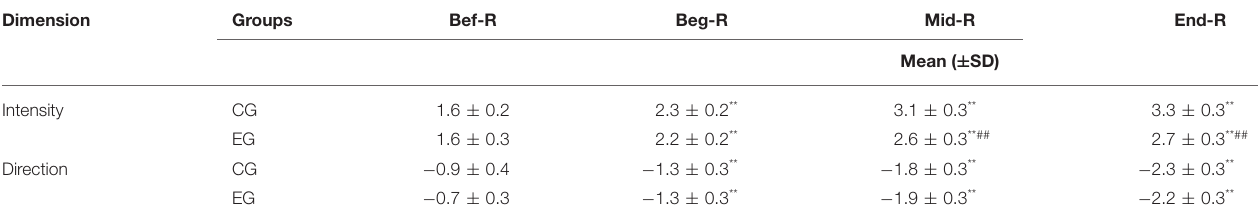
TABLE 5 | Variation in the dimensions of somatic anxiety recorded before and during Ramadan. Dimension Groups